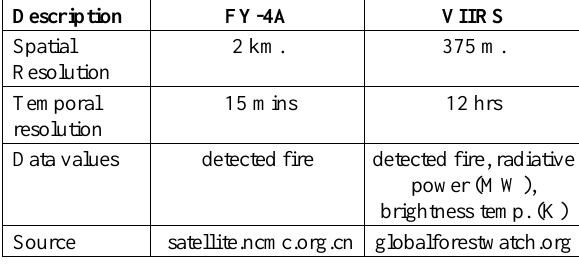
Table 2 . Summary of VIIRS and FY-4A data desciptions.